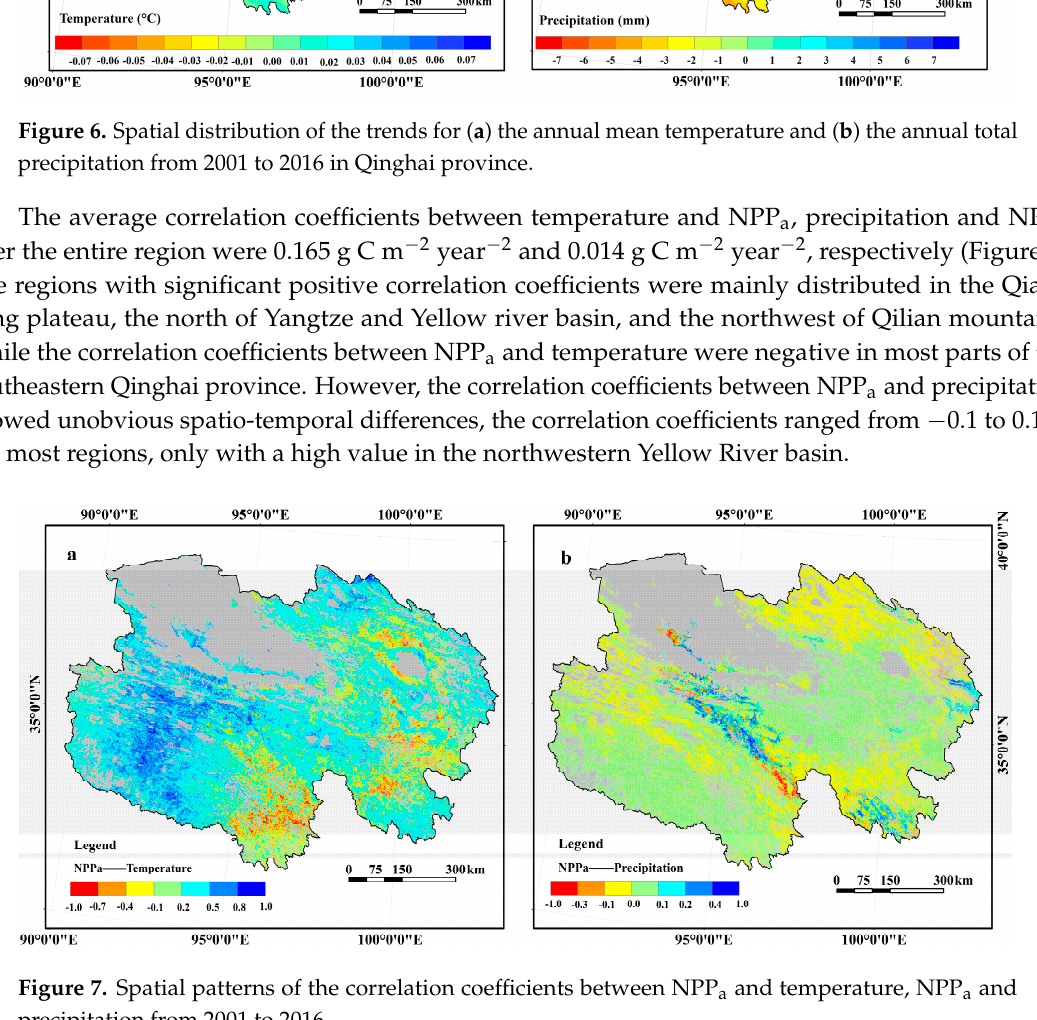
Figure 6. Spatial distribution of the trends for ( a ) the annual mean temperature and ( b ) the annual total precipitation from 2001 to 2016 in Qinghai province.